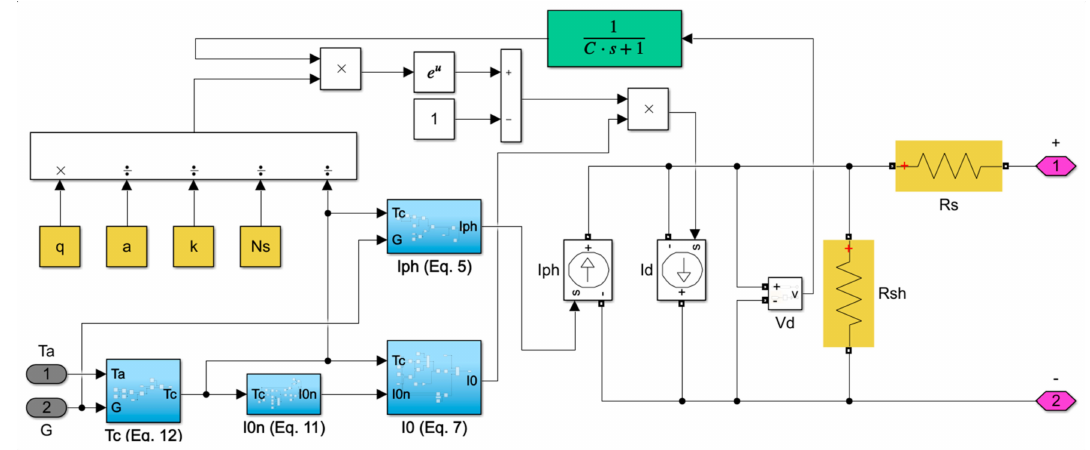
Figure 2. MATLAB / Simulink ® PV module